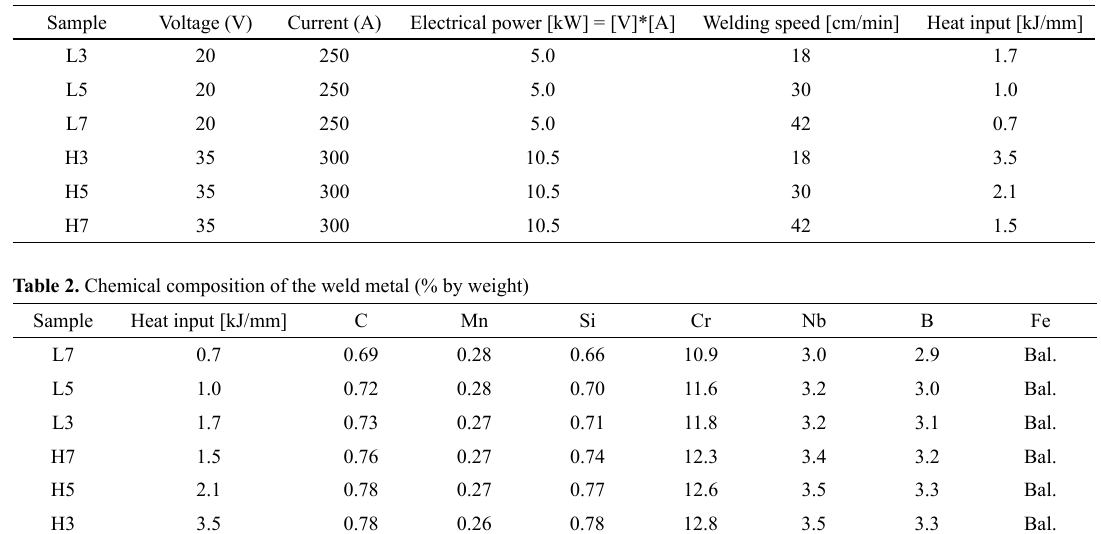
Table 1. Welding parameters